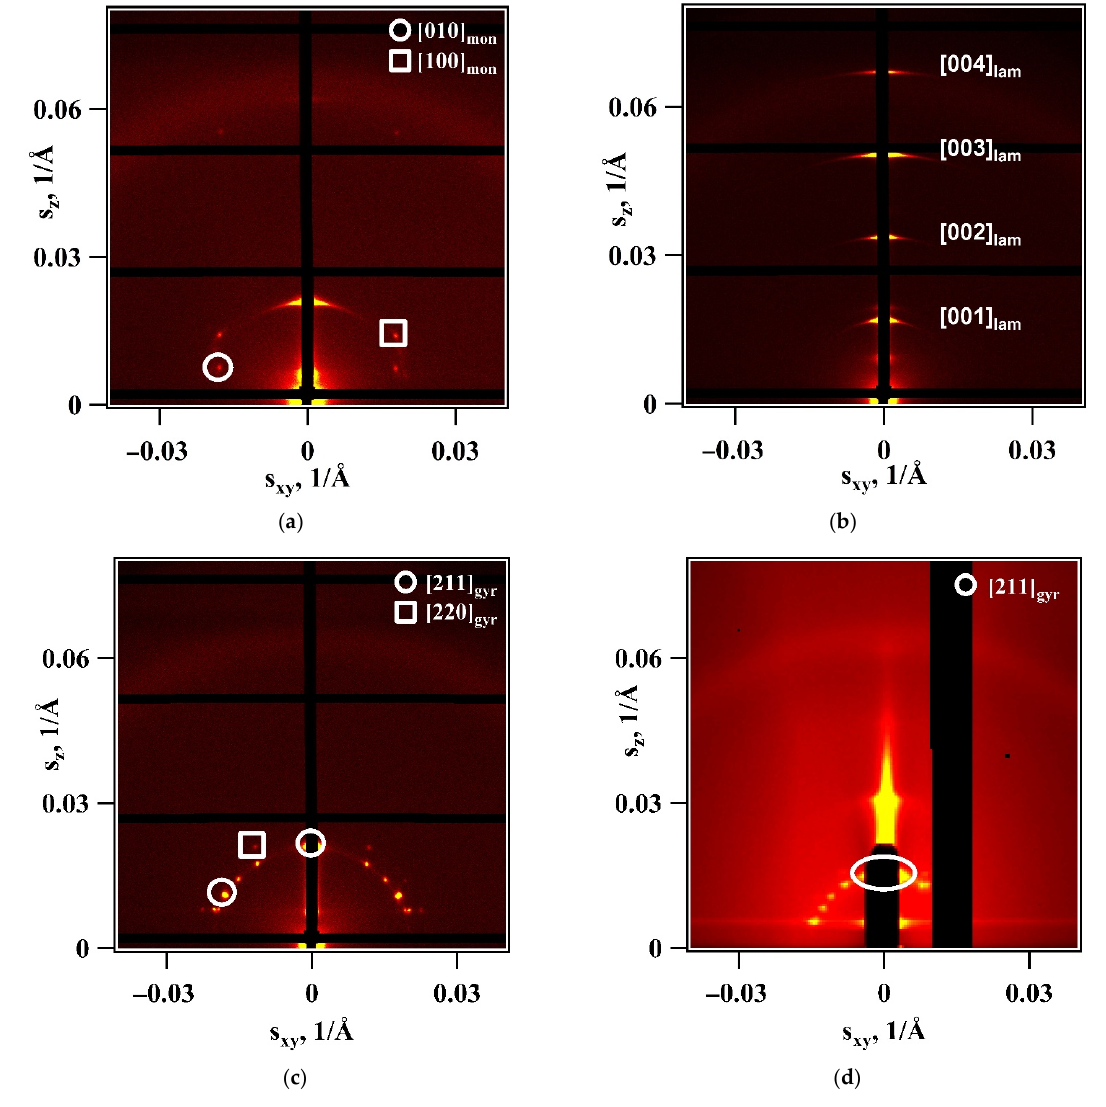
Figure 4. Two-dimensional GISAXS pattern of a dry C8AzoPyr thin film. ( a ) Col mon phase formed after long annealing at room temperature; ( b ) lamellar phase formed upon swelling in methanol vapors for two hours at room temperature; ( c ) Cub gyr phase generated after long-term annealing at ambient conditions; ( d ) Cub gyr phase swollen in water vapors for two days at room temperature.